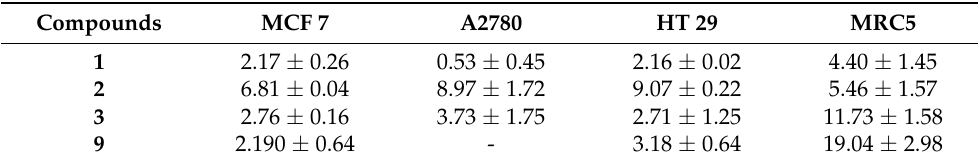
Table 1. Activity of the half-maximal inhibitory concentration (IC 50 µ M ± SD; 72 h) of compounds 1 – 3 and 9 against three cancer cell lines and one normal fibroblast cell line evaluated by MTT assay (72 h).